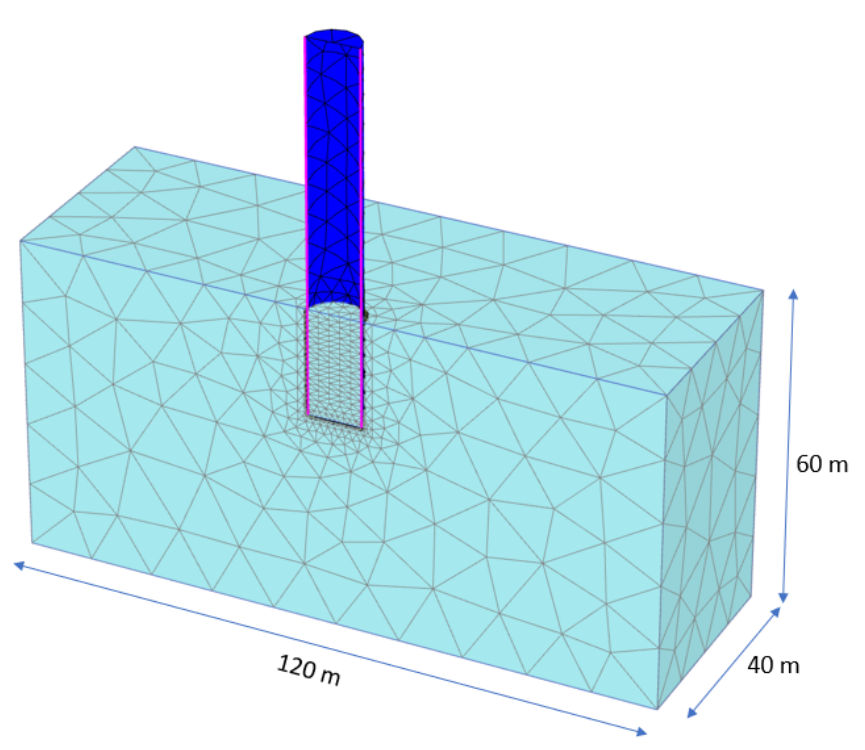
Figure 3. Finite element mesh of Model 1.